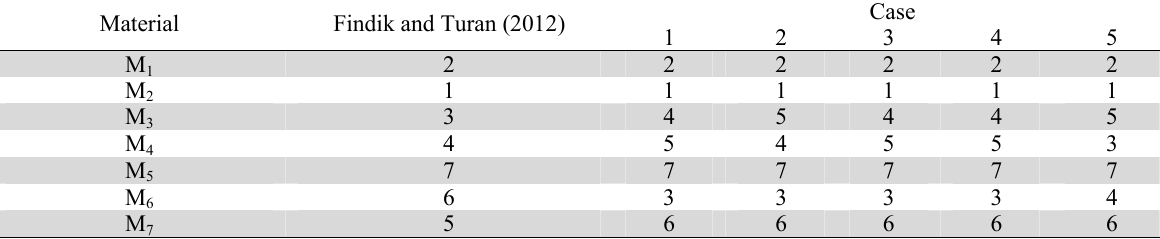
Rankings of light load wagon wall materials using VIKOR method